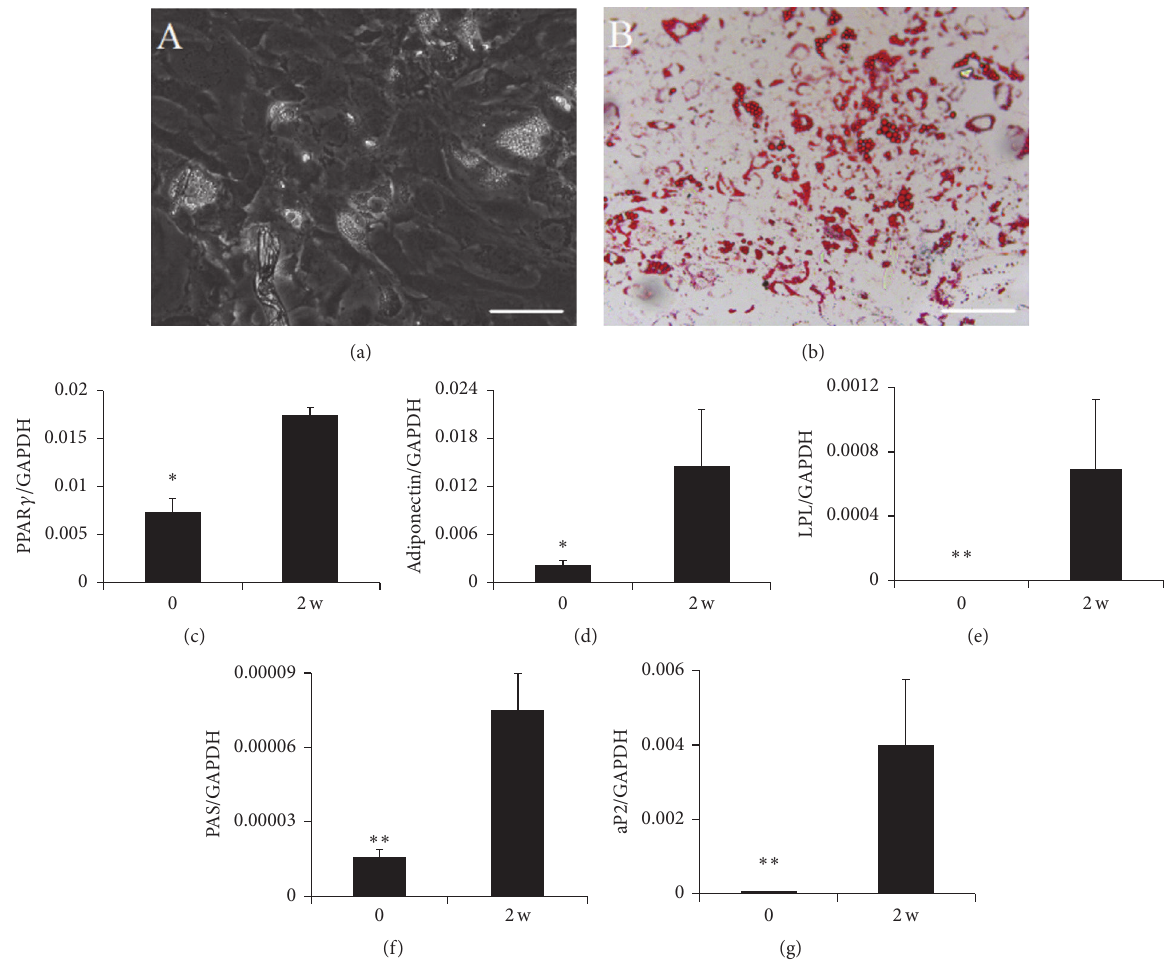
Figure 4: Adipogenic differentiation potential of third-passage MSCs cultures derived from meniscal debris. After 14-day induction in adipogenic medium, adipogenesis was detected as the formation of neutral lipid vacuoles (a) stainable with Oil Red O (b). Scale bar = 200 𝜇 m. Expression of adipogenic genes PPAR 𝛾 (c), adiponectin (d), LPL (e), PAS (f), and aP2 (g) was assessed by real-time PCR. Data are presented as mean ± SD. ∗ 𝑃 < .05 ; ∗∗ 𝑃 < .01